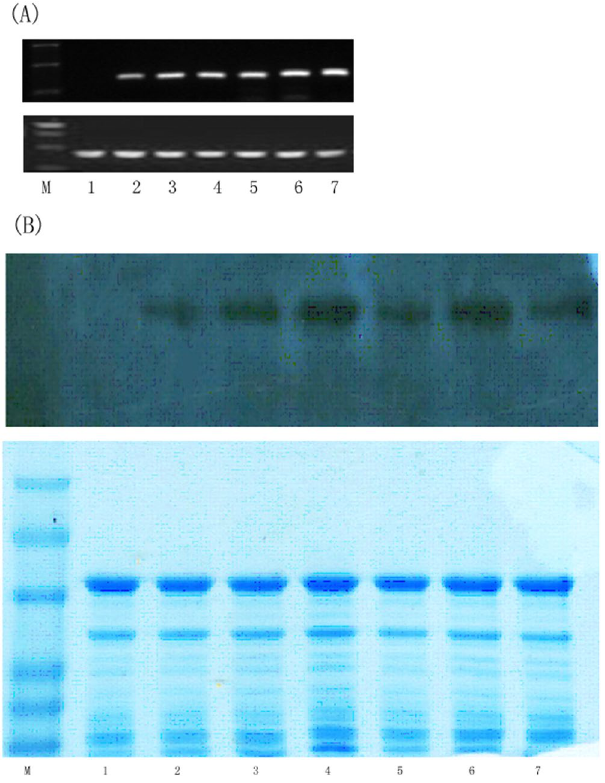
Figure 1. ( A ) Expression of StGWD1 in the developing endosperm of stable offspring lines of transgenic rice (RGD1-6) at the transcript level determined by qRT-PCR (up: StGWD1 , down: actin), and ( B ) StGWD1 protein determined by western blotting (up: StGWD1, down: the total protein). The gels were cropped to only show the relevant bands. M: marker, 1: control, 2-7: